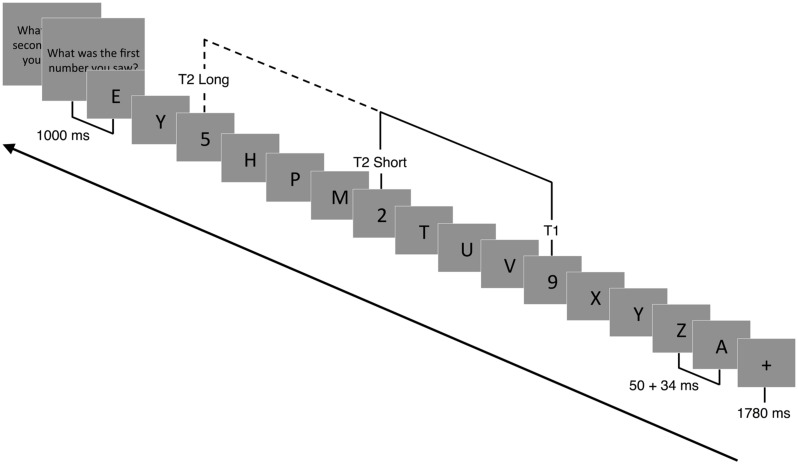
Attentional blink paradigm. Following a 1780 ms fixation cross (+), a RSVP of 15 or 19 capital letters (distractors) were displayed focally on a computer screen. Embedded within the RSVP were 1 (T1 present-T2 absent) or 2 (T1 present-T2 present) target numbers. Each slide was presented for 50 ms followed by a 34 ms blank slide. Participants had to detect T1 and T2 (if present) and report their response at the end of each trial. In T2 absent trials, T2 was replaced with a blank screen. The temporal lag between T1 and T2 could vary between 336 ms (short trials) and 672 ms (long trials).